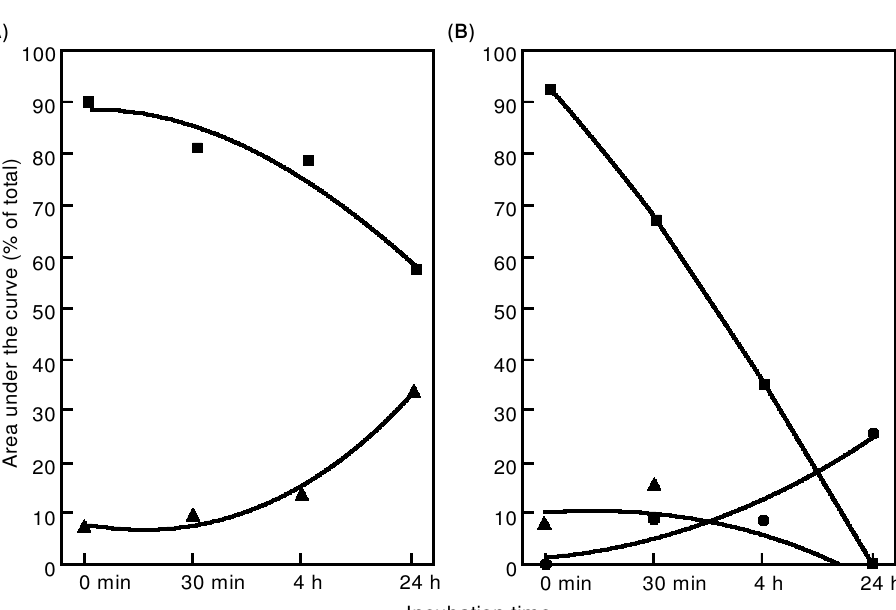
FIG. 3. Metabolism of [ 3 H]-PGD 2 in PBS (A) and culture medium containing FCS (B). After incubation of [ 3 H]-PGD 2 in PBS or culture medium, samples were processed as described in the Methods section. [ 3 H]-PGD 2 and its metabolites were detected by continuous radiodetection in the HPLC eluate. [ 3 H]-PGD 2 ( j ), [ 3 H]-PGJ 2 ( m ) and [ 3 H]- D 12 -PGJ 2 ( d ) were identified by co- migration with authentic unlabelled standards. [ 3 H]- D 12 -PGJ 2 could only be detected in culture medium containing FCS.